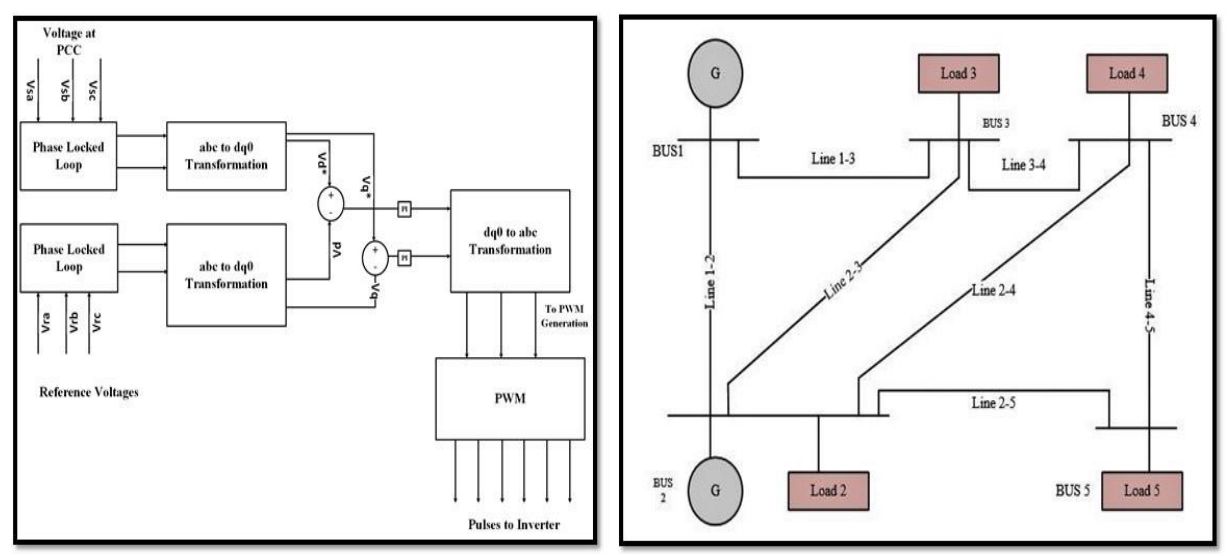
Fig.2 Control System of DVR Fig.3 IEEE 5 BUS